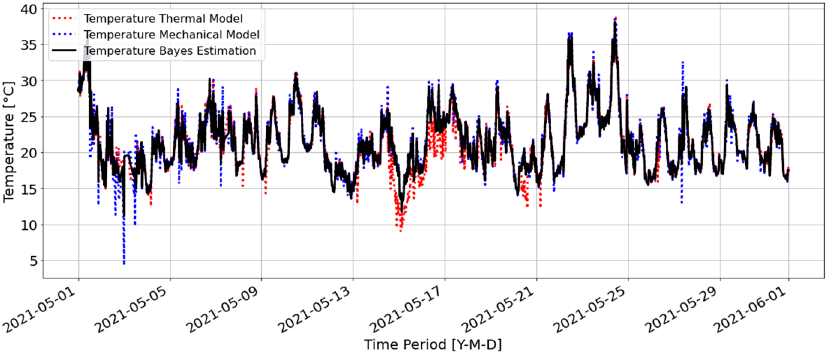
Figure 6. Zoom temperature trends for a specific period: thermal model (dashed red line); mechanical model (dashed blue line); Bayesian temperature (black line).